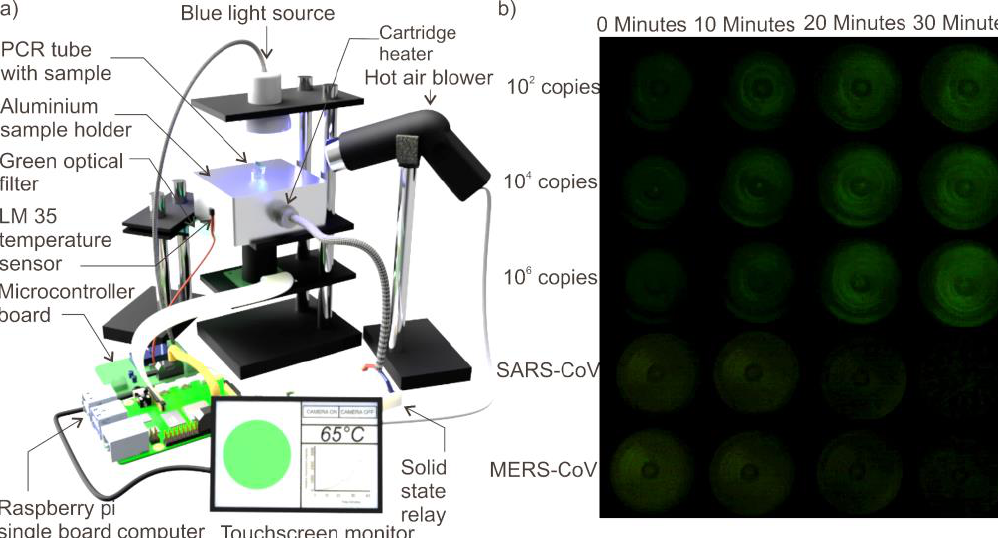
Figure 1. ( a ) Schematic of the experimental setup. ( b ) Photographs of fluorescence emitted from various samples upon performing the loop mediated isothermal amplification (LAMP).